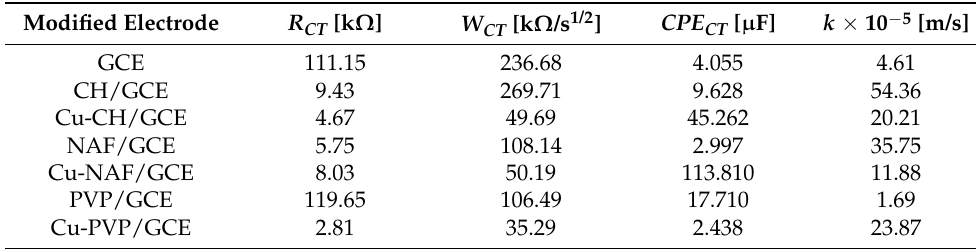
Table 2. Summary of equivalent circuit parameters and heterogenic rate constants of the electrode reaction evaluated based on EIS